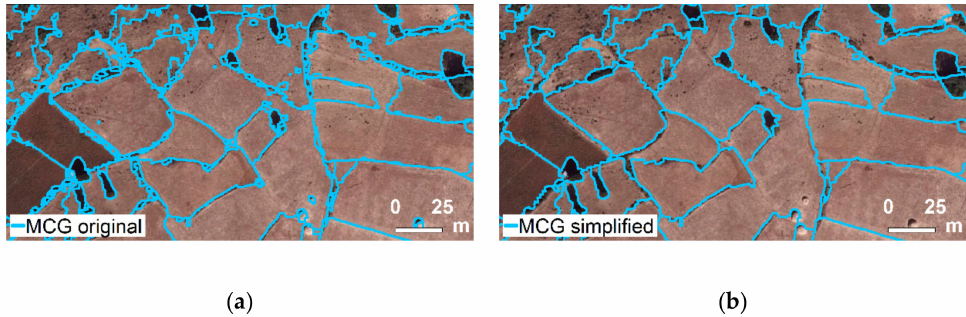
Figure 3. Multiresolution Combinatorial Grouping (MCG) image segmentation lines around visible objects ( a ) before and ( b ) after simplification reducing the line count by 80%.